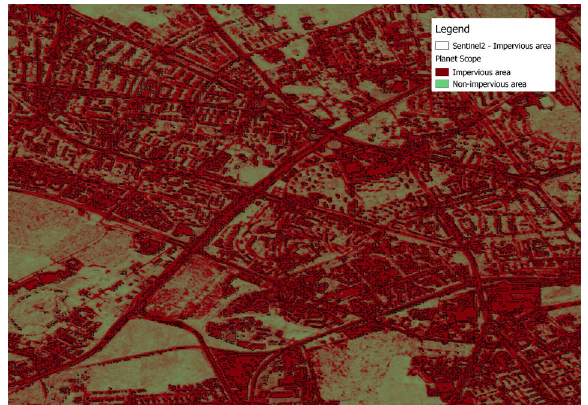
Fig. 7 . C omparison of SENTINEL - 2 NDVI products with Planet Scope.